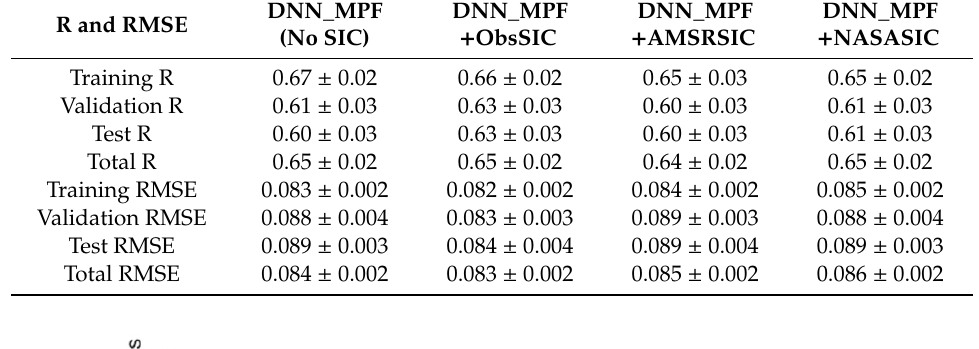
Table 3. Mean correlation coefficients and RMSE against the observations in training, validation, test, and total datasets for the four network combinations.